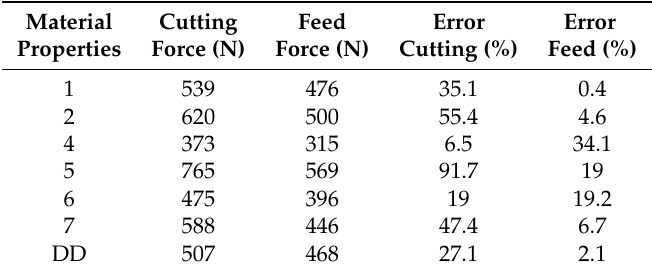
is measured with respect to experimental results presented in Table 5 using Equation (22). DD is an abbreviation for the dislocation density model.